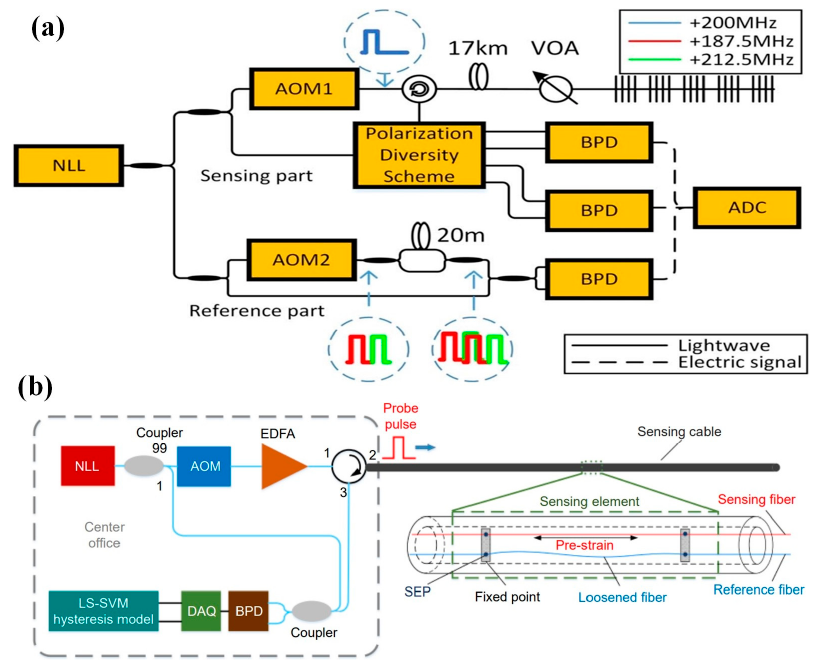
Figure 12. Representative scheme for low-frequency noise suppression: ( a ) auxiliary interferometer compensation [60,61]; ( b ) reference fiber compensation [62].